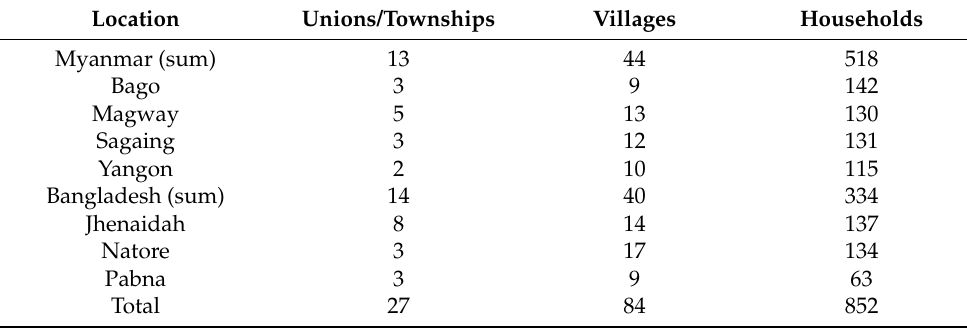
Table 1. Geographic distribution of the quantitative sample of mungbean farmers.